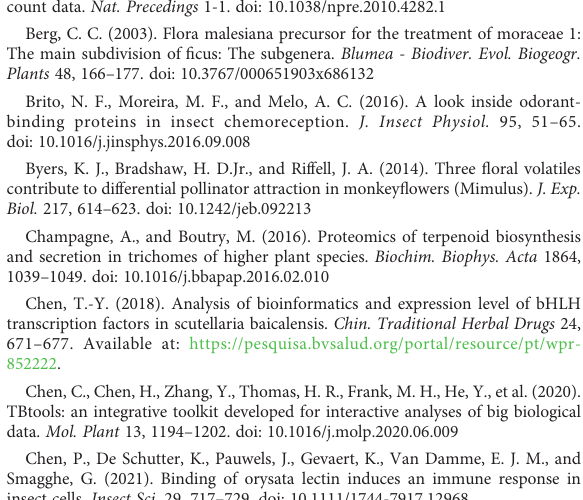
Pearson Correlation Coef fi cient analysis of the transcriptome and proteome. FhirtaA VS FhirtaB represent multiples of transcript expression in both A phase and B phase of F. hirta bracts. CuA VS CuB represent multiples of protein expression in both A phase and B phase of F. hirta